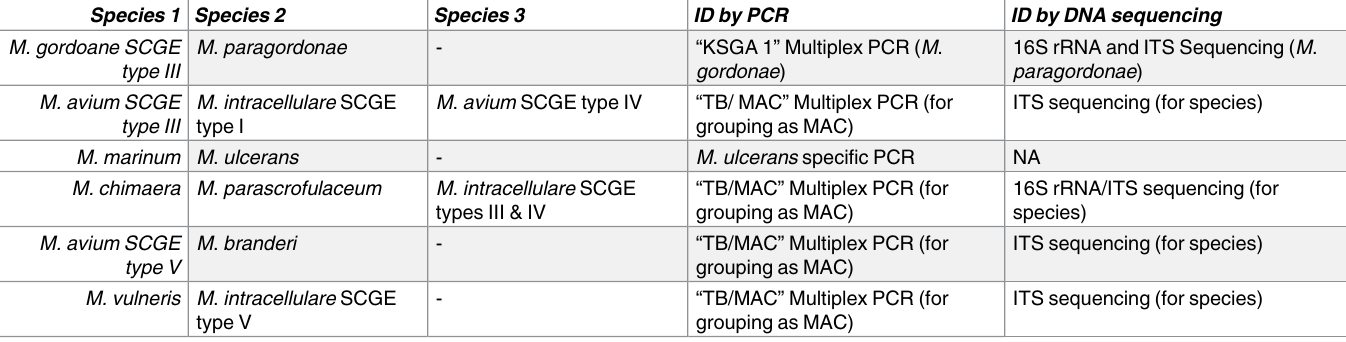
Table 3. Slowly growing mycobacterium species which demonstrated overlap of SCGE fragment lengths and the methods required to resolve species identification.